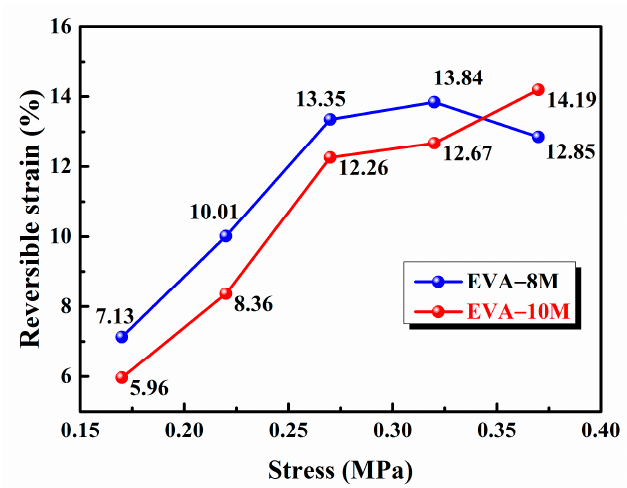
Figure 8. E ff ect of UV curing time and applied stress on the reversible strain of the crosslinked EVA fibers. (Reversible strain was calculated by the fifth heating-cooling cycle).